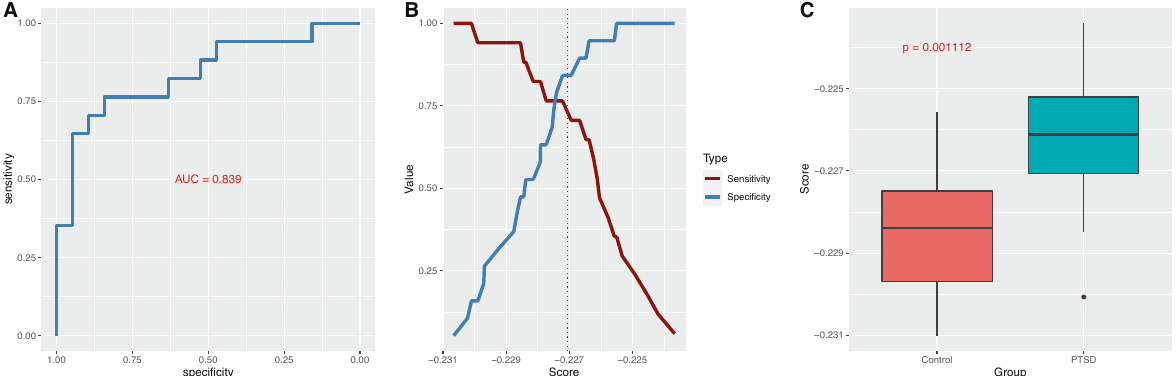
Fig. 1 Multi-metabolite model evaluation. A AUC plot in the test set. B Plot of sensitivity versus speci fi city. The vertical dotted line corresponds to the optimal cutoff according to the Youden method. C Boxplot comparing the multi-metabolite composite score in the test set.